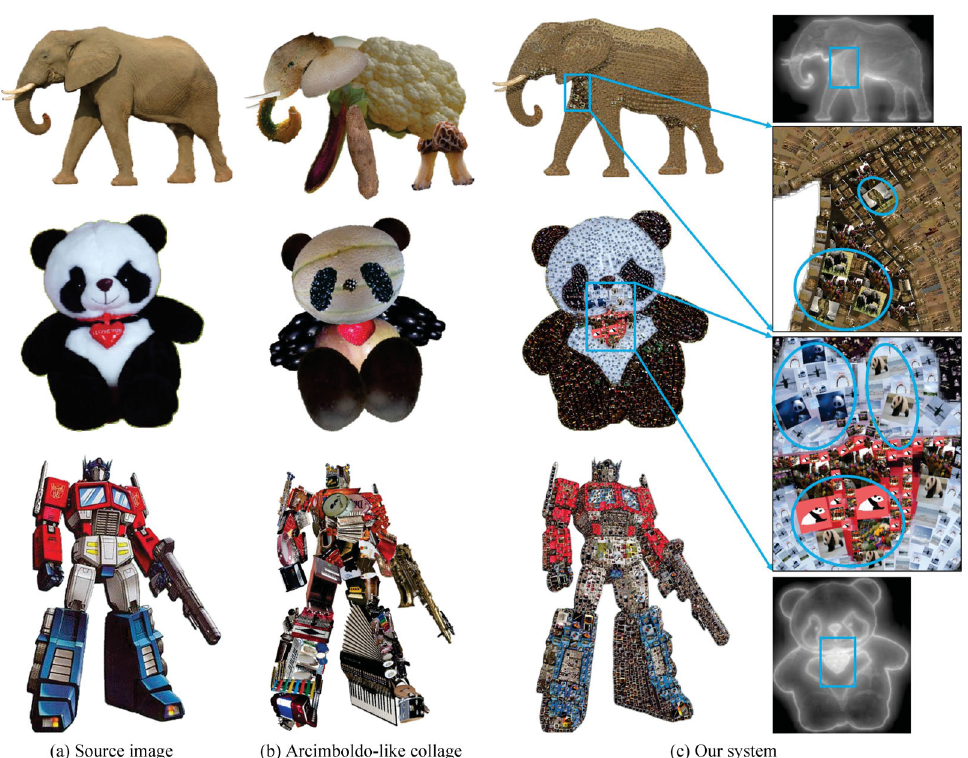
Fig. 11 Comparison with Arcimboldo-like collage. Left to right: (a) source image, (b) results of Arcimboldo-like collage, (c) results of our system. Detailed views of salient areas of the elephant and panda images are shown on the far right.